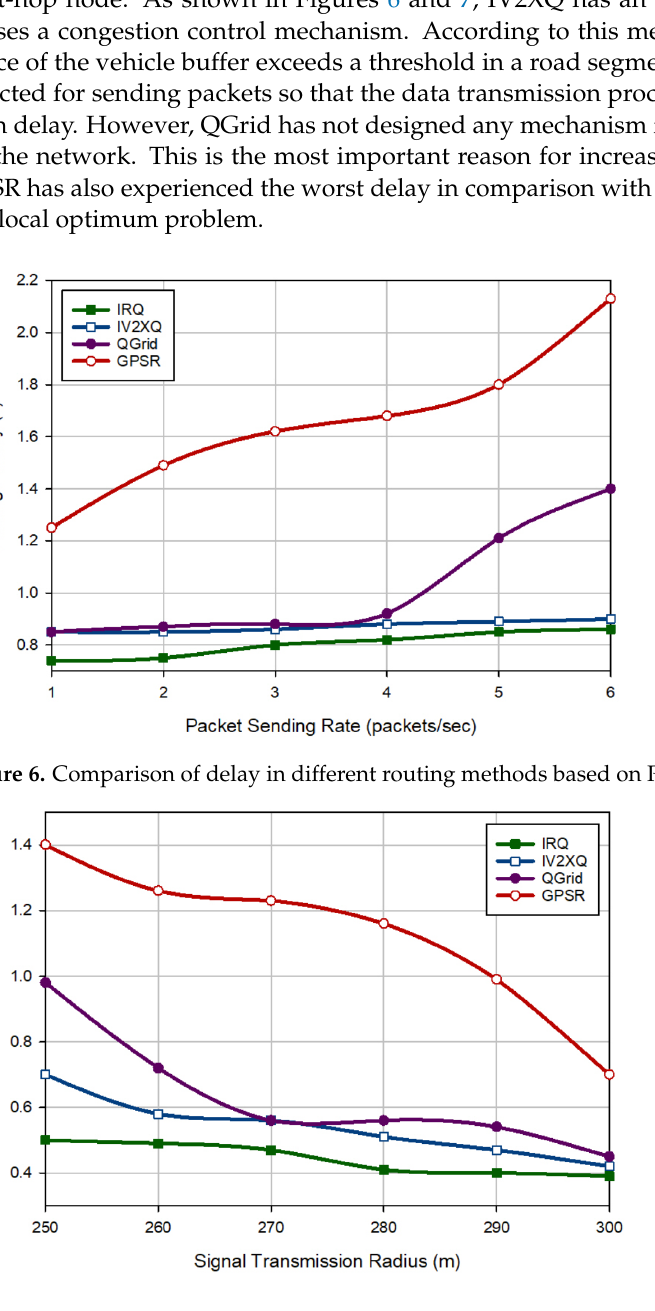
Figure 7. Comparison of delay in different routing methods based on